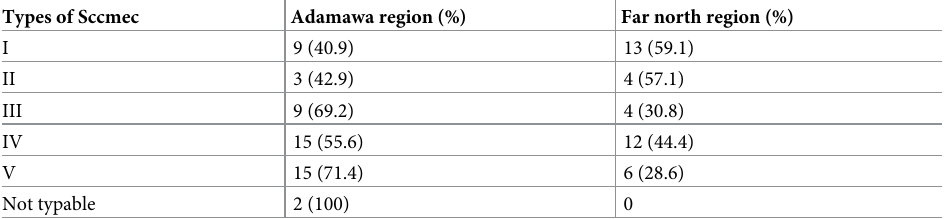
Table 4. Region wise distribution of SCCmec types among clinical samples collected from the Adamawa and Far north regions of